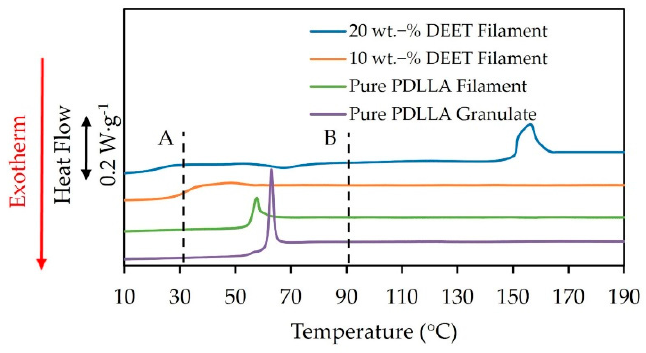
Figure 6. DSC heating scans, recorded at a heating rate of 5 K · min − 1 , of PDLLA monofilaments containing different amounts of DEET.